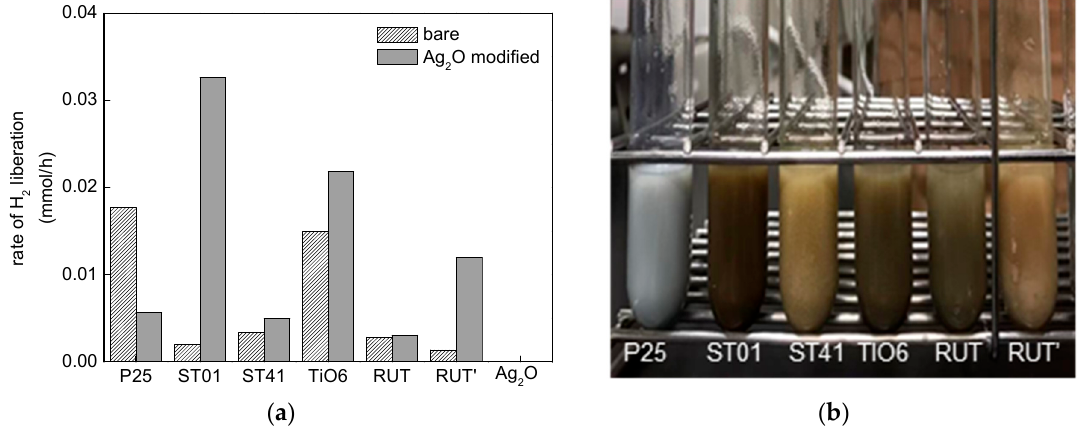
Figure 5. UV/vis photocatalytic efficiency of Ag 2 O/TiO 2 samples with a different titania matrix in methanol dehydrogenation reaction ( a ) with respective photographs of samples after 45-min irradiation ( b ).